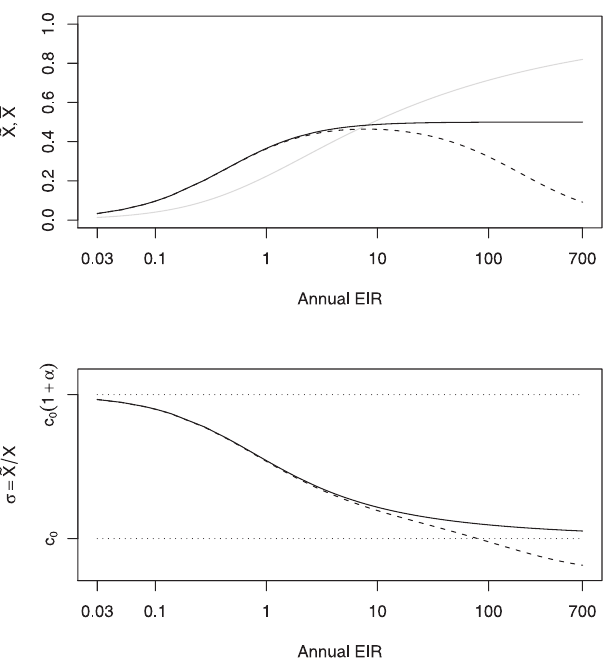
Figure 3. The Index of Sampling Bias, r (Top) The PR (grey line) rises monotonically with EIR. The fraction of mosquitoes that become infected after biting a human, X˜ , is initially higher than the PR because of heterogeneous biting, but at high EIR, PR continues to rise while X˜ remains flat without transmission-blocking immunity (solid black line) or declines with it (dashed line). (Bottom) Without transmission-blocking immunity, the index of sampling bias, r , declines from near c 0 (1 þ a ) to c 0 (solid black line). At low EIR, the estimates of PR from a well-designed study underestimate the probability a mosquito becomes infected. At high EIR, without transmission-blocking immunity, this bias becomes insignificant. At high EIR, with transmission-blocking immunity, the PR in children substantially overestimates infectivity (dashed line). These graphs assume heterogeneous biting and model transmission- blocking immunity as in equation 20, with c ¼ 0.001 (Methods).